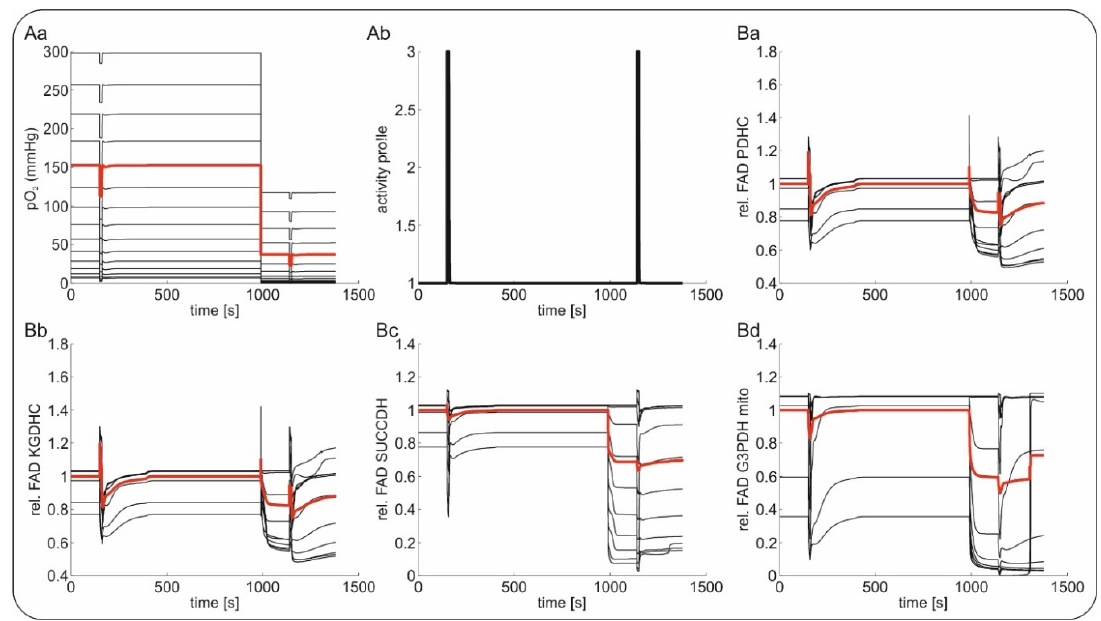
Figure 3. In silico reconstruction of the Flavin adenine dinucleotide (FAD) redox state during hypoxia in brain slices. ( Aa ) Reconstruction of tissue oxygenation (O 2 ) gradients in a brain slice in experimental conditions under 95% and 50% oxygenation. ( Ab ) Similar to the increased energy demand elicited experimentally by electrical stimulation trains (20 Hz / 2 s), periods of increased neuronal activation were simulated in silico by increasing intracellular Ca 2 + , which generated an activity-dependent drop in intracellular ATP. ( Ba – d ). Simulations of changes in FAD fluorescence in di ff erent layers during 95% and 50% O 2 of pyruvate dehydrogenase (PDHC, ( Ba )), α -ketoglutarate dehydrogenase (KGDHC, ( Bb )), succinate dehydrogenase (SUCCDH, ( Bc )) and mitochondrial glycereol-3-phophate dehydrogenase (G3PDHmito, ( Bd )). Black lines depict the di ff erent layers of the slice; the red line gives the mean signal of all black lines.